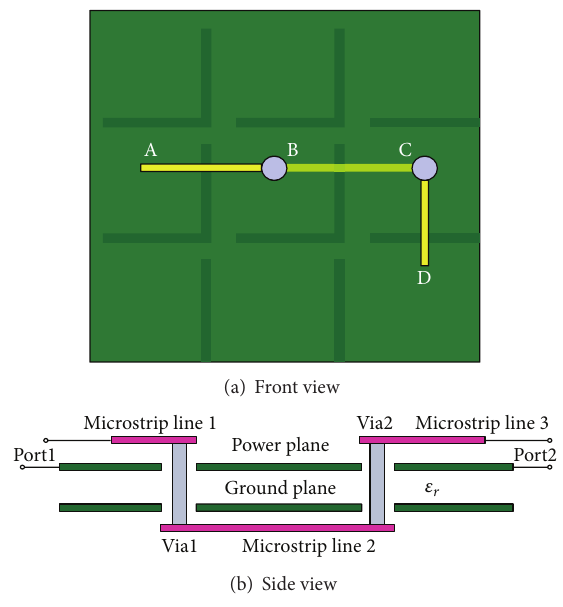
Figure 25: Signal